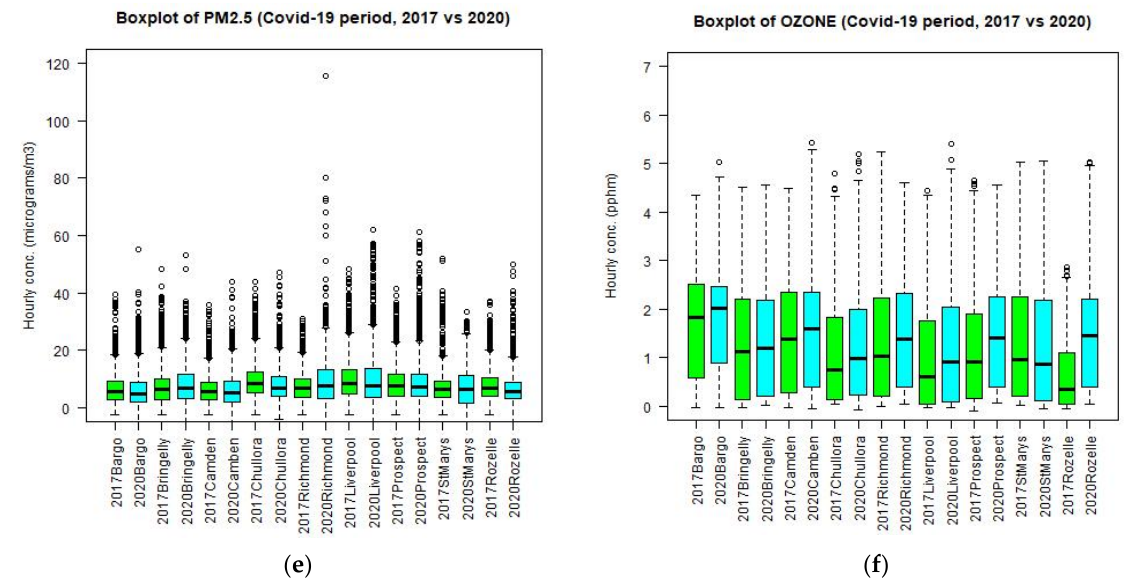
Figure 10. Boxplot of PM 2.5 and ozone at different sites in the GMR in 2019 and 2020 side by side for the period from April to June ( a ) and ( b ). Boxplot of PM 2.5 and ozone in 2018 and 2020 side by side ( c , d ). Additionally, in 2017 and 2020 side by side ( e , f ).